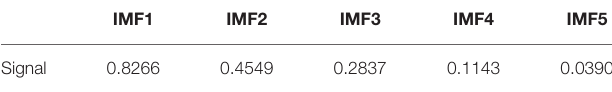
TABLE 1 | Correlation analysis of the original seismic trace and their five corresponding IMFs extracted by